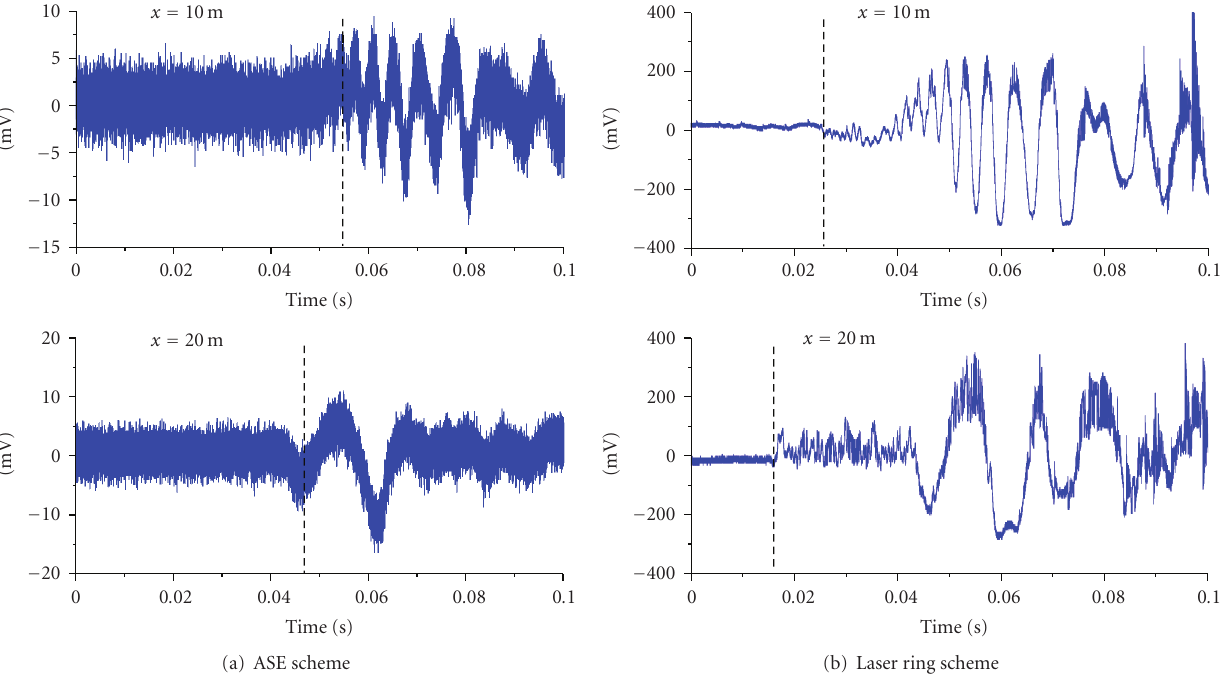
Figure 6: Impact Signals obtained from the wind turbine blade using (a) the ASE light source and (b) the laser ring scheme. (Dotted lines indicate the signal first arrival